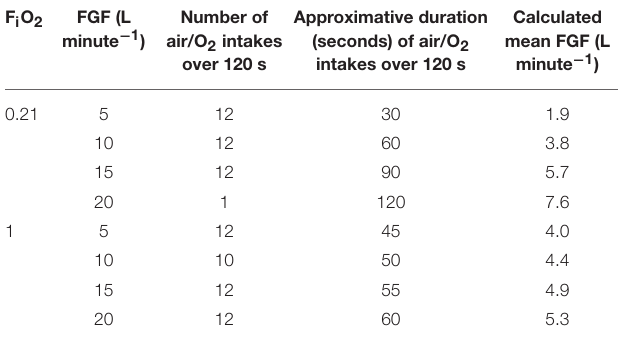
TABLE 1 | Calculation of the mean fresh gas flows (FGF) at the common gas outlet of the Tafonius anesthesia machine with the computer-controlled flowmeter (CF) set at different F i O 2 and FGF based on outflow measurements, frequency, and duration of the air or O 2 intakes. F i O 2 FGF (L minute − 1